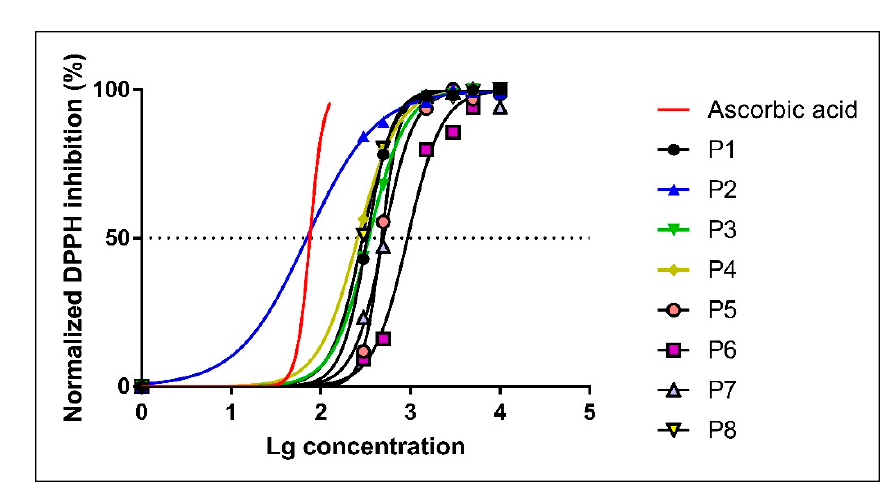
Figure 3. Dose-response curves for DPPH radical scavenging activity of the propolis samples.